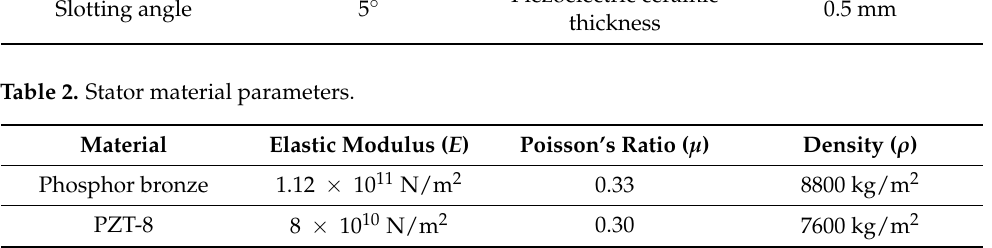
Table 2. Stator material parameters.